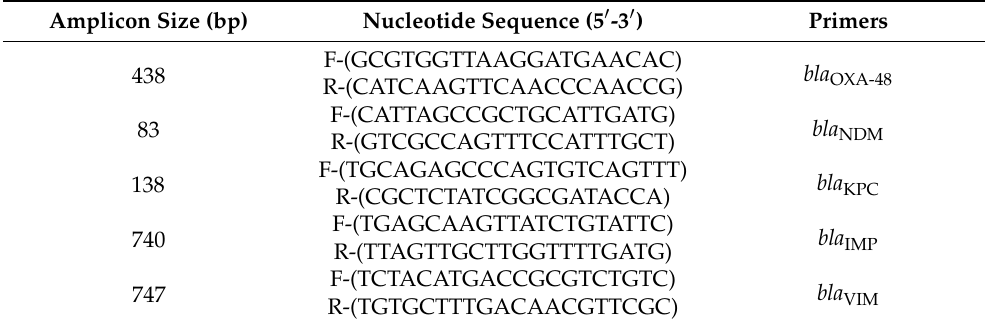
Table 9. Sequence and expected product sizes of primers used to amplify bla OXA-48, NDM, KPC, IMP, and VIM